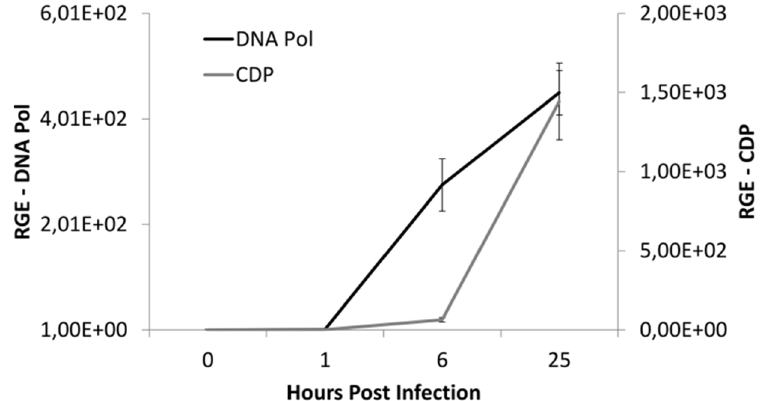
Figure 4. Relative expression of TsV genes TsV_019 and TsV_014, encoding for putative DNA Polymerase (DNA Pol) and Capsid Decoration Protein (CDP), respectively. RGE, relative gene expression units.